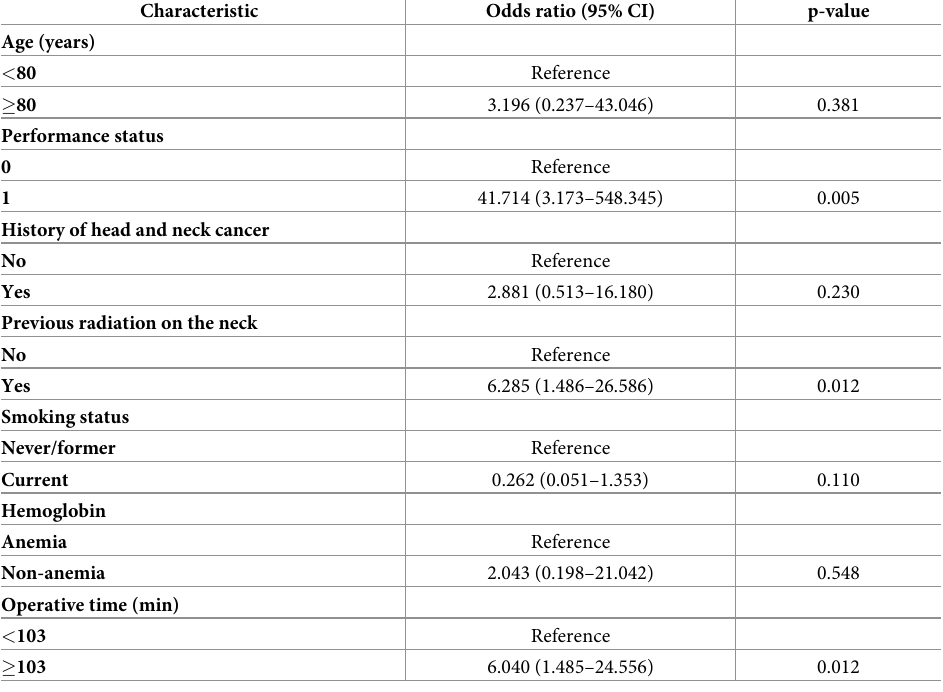
Table 3. Multivariate